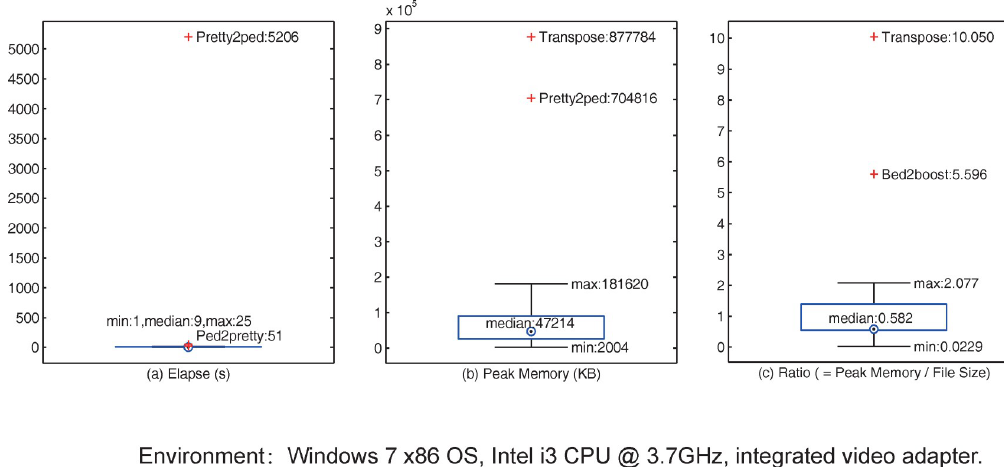
Fig 2. Elapsed time and peak memory of